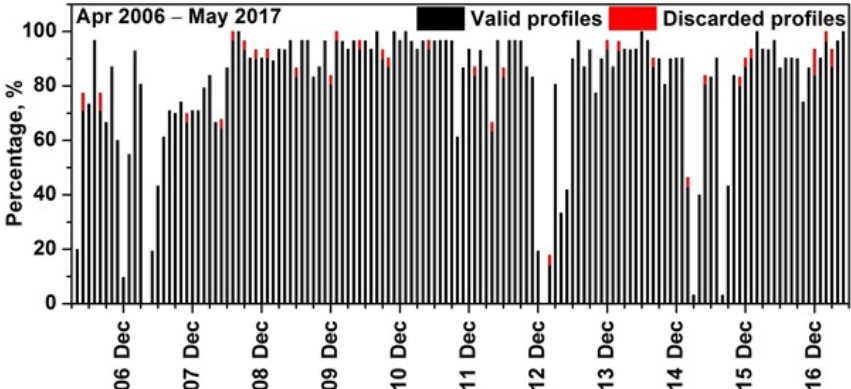
Figure 1. Monthly percentage of radiosonde data available during April 2006–May 2017 at Gadanki. The percentage of discarded profiles in each month is also shown in red.